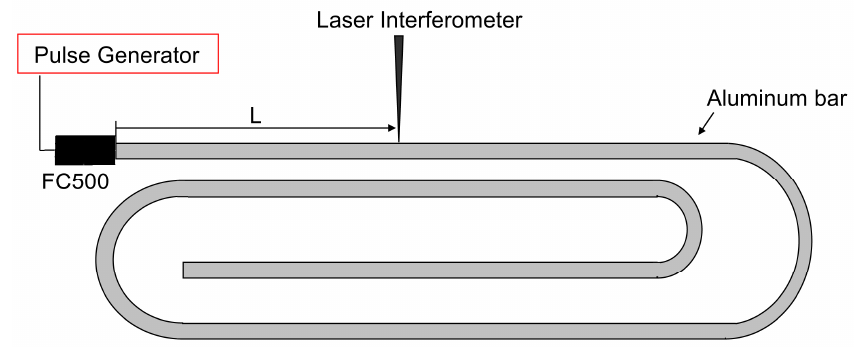
Figure A1. A bar-wave calibration set-up [10]. Bar size was 6.4 mm × 25.4 mm × 3600 mm.